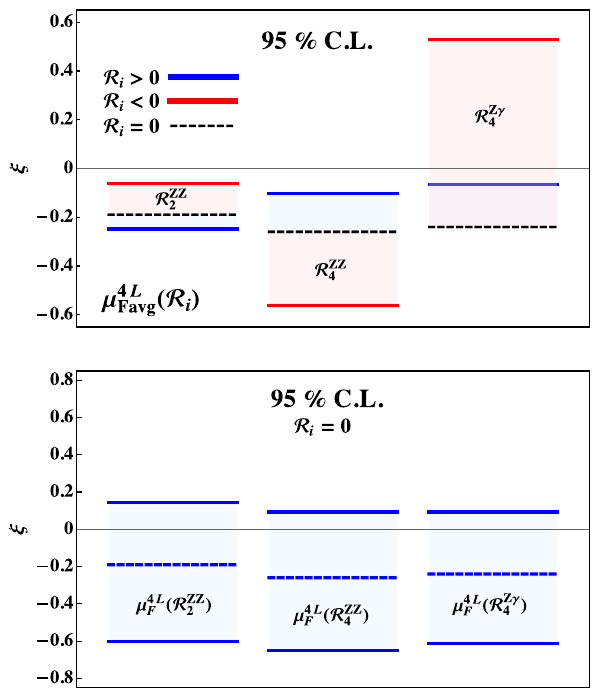
Fig. 3 Lower: fits to ξ using the rate information in the H → 4L chan- nel, assuming the anomalous HVV couplings vanish. Upper: fits to ξ using the shape information and the constraints on R V text for more